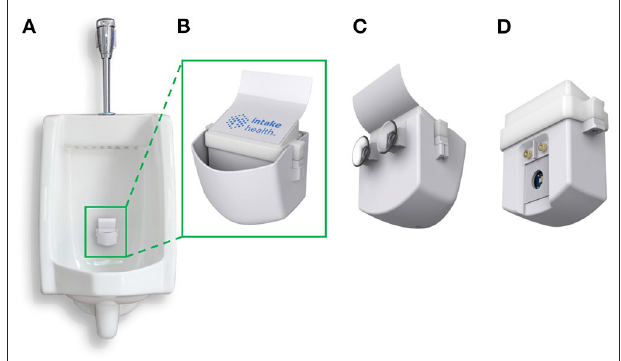
FIGURE 1 | The InFlow Urinalysis System. (A) Fully assembled system installed in a urinal using rear suction cups capable of catching a stream of urine in real-time. Urine fills the cup at a rate faster than it can drain through a hole in the bottom. (B) The front, fully assembled InFlow system magnified. LED lights under the top of the insert housing flash red, yellow, or green to categorize results for the user as dehydrated, mildly dehydrated, and hydrated, respectively. (C) Rear view of the full assembly showing suction cups for installation. (D) Rear view of the removed insert sub-assembly showing the sensors that interface with the urine sample during use. As urine fills the cup, fluid engulfs the insert from the bottom. The metal electrodes register the presence of fluid by shorting the pin voltage and initiate testing via the LED and photodiodes residing behind a glass window.